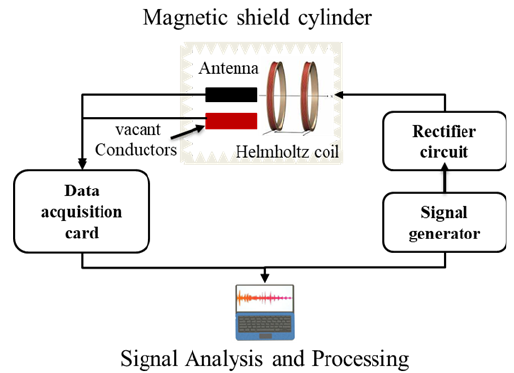
Figure 5. Weak magnetic test system principle.